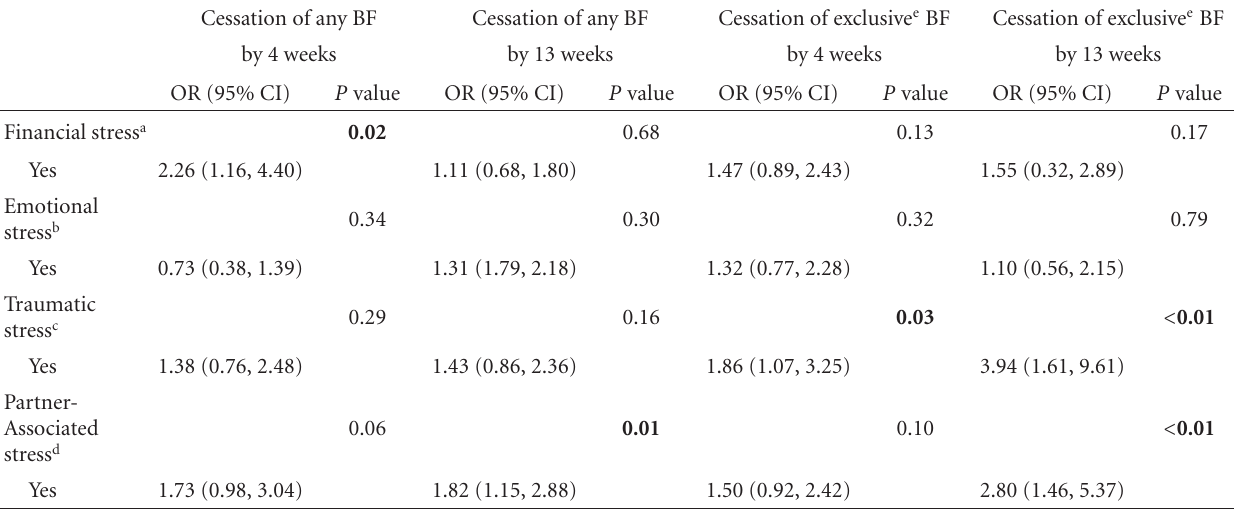
Table 3: Comparison of stress categories and breastfeeding outcomes modeling for breastfeeding